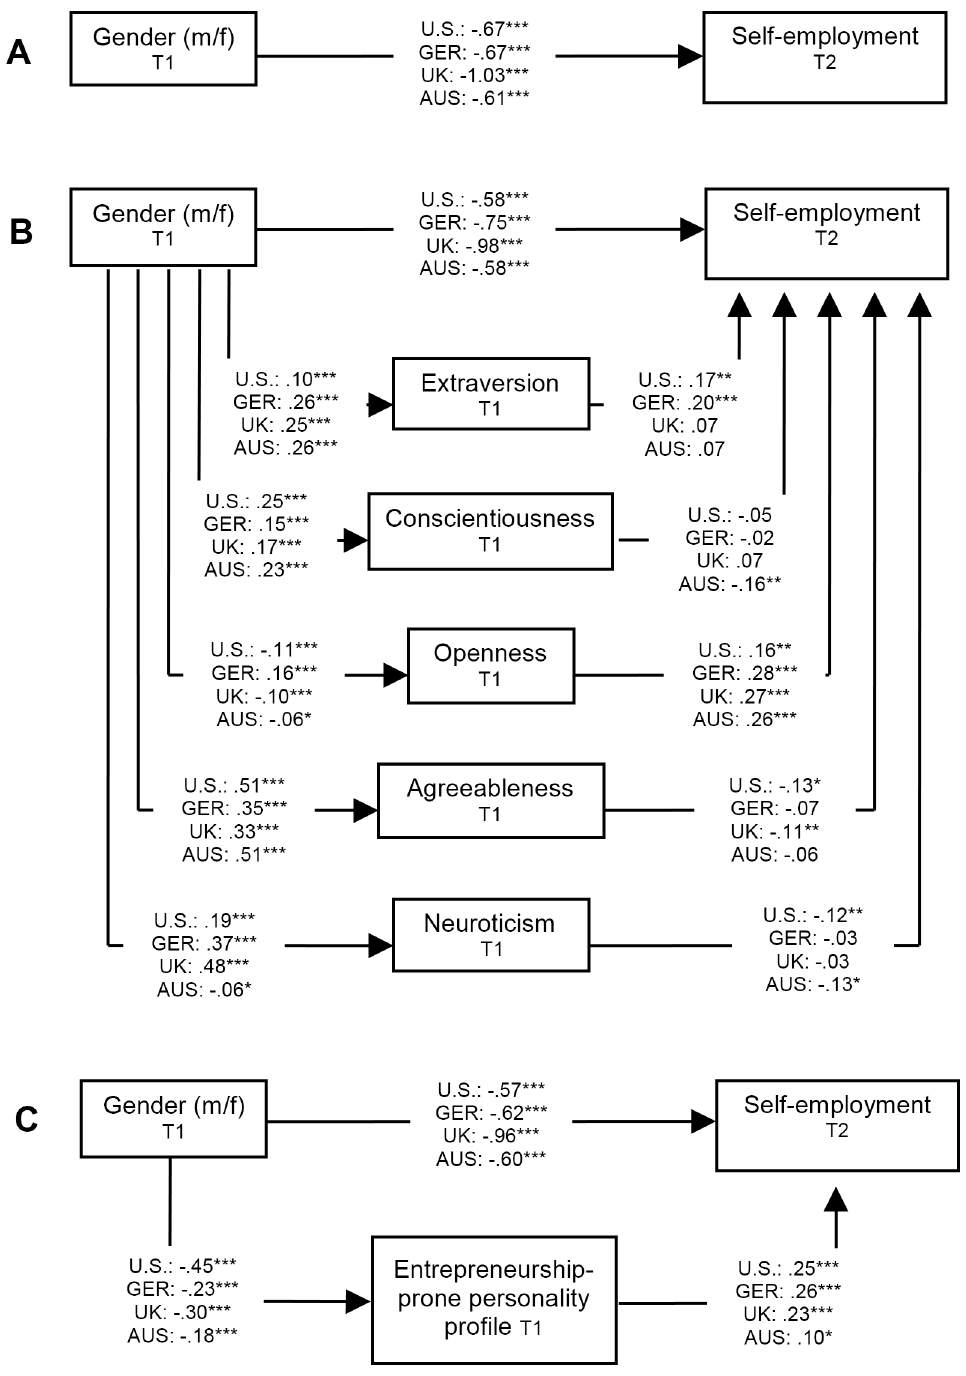
Figure 1. Mediation results across the four countries. A) Direct effect model, B) Mediation model with single Big Five traits as mediators, C) Mediation model with the entrepreneurship-prone personality profile as mediator. Note . All effects are controlled for age, age 2 , education, (and education 2 in the German and Australian analysis). Unstandardized coefficients are given. All personality variables are z-standardized. U.S.=United States of America, GER=Germany, U.K.=United Kingdom. AUS=AUSTRALIA. * p , .05. ** p , .01. *** p , .001. doi:10.1371/journal.pone.0103805.g001 of gender through openness on self-employment status was.04 When testing the entrepreneurship-prone Big Five profile (SE = .01; 95%CI= .03 and.06). As these indirect effects are both instead of the single traits as mediator (Figure 1C), we again found a significant mediation effect of the profile. Gender in the opposite direction than the direct effect, this does not indicate mediation but suppression. negatively predicted the profile ( B = 2 .23, SE = .02, p , .001), which in turn positively predicted self-employment status ( B = .26,